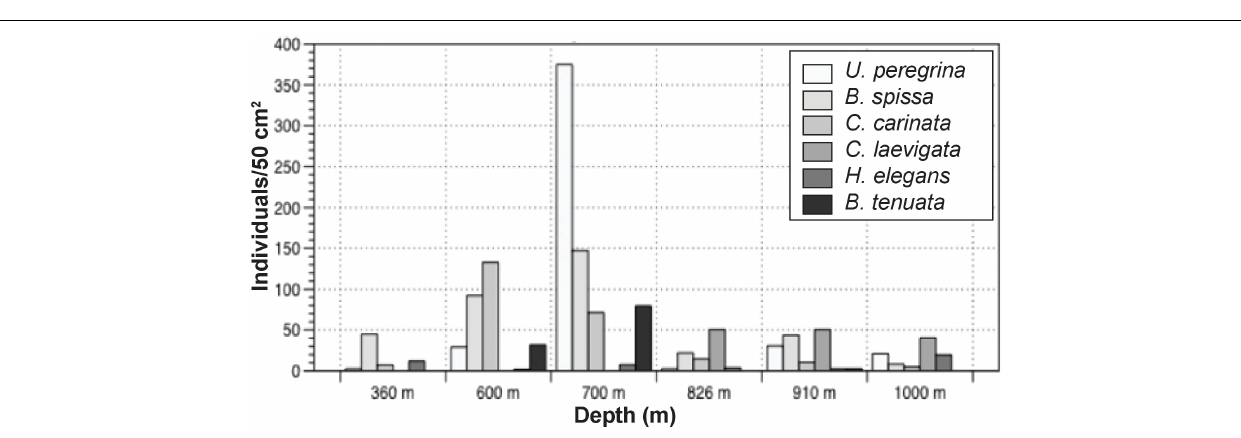
FIGURE 5 | Distribution of the six most abundant > 63 micron taxa along the